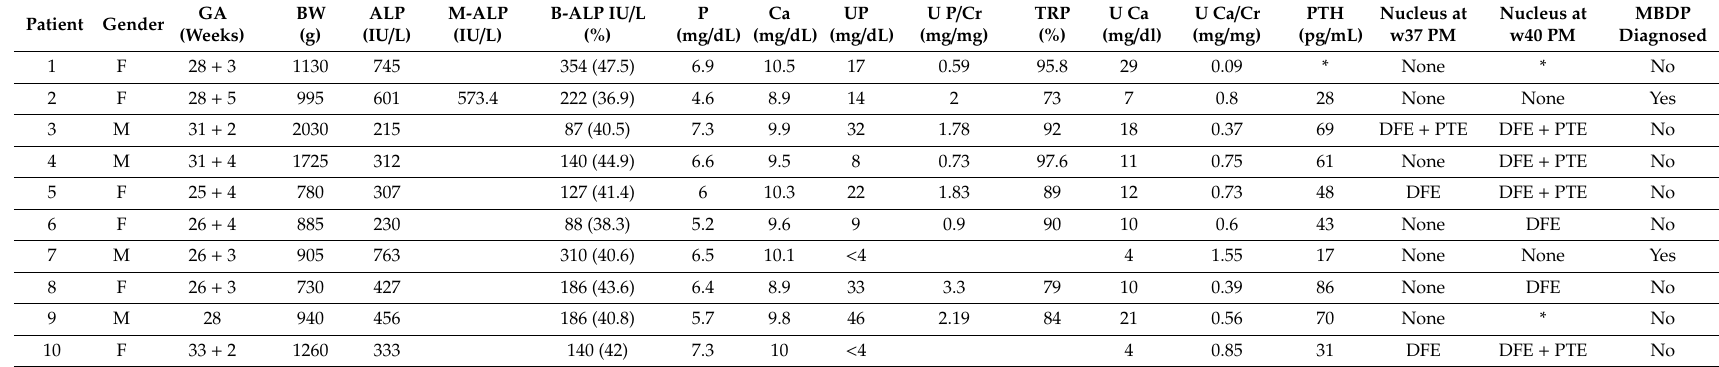
Table 4. Preterm features in the Prospective Group (PG). Analytic values at 4 weeks of life, presence / absence of the DFE and PTE nucleus and MBDP condition. M-ALP was calculated only in patients with neonatal